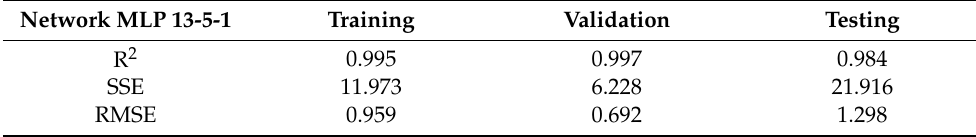
Figure 11. Multilayer perceptron network used in the process of prediction. Table 1. Results of teaching, validation and testing for the prediction with MLP